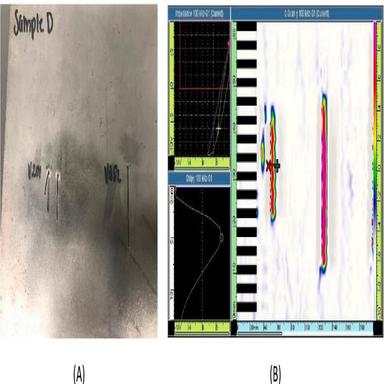
Eca testing for calibration sample with vertical notches (sample D); (A) steel sample with waterjet made notches, and (B) impedance plane, voltage and C-SCAN results of the notches by ECA testing.